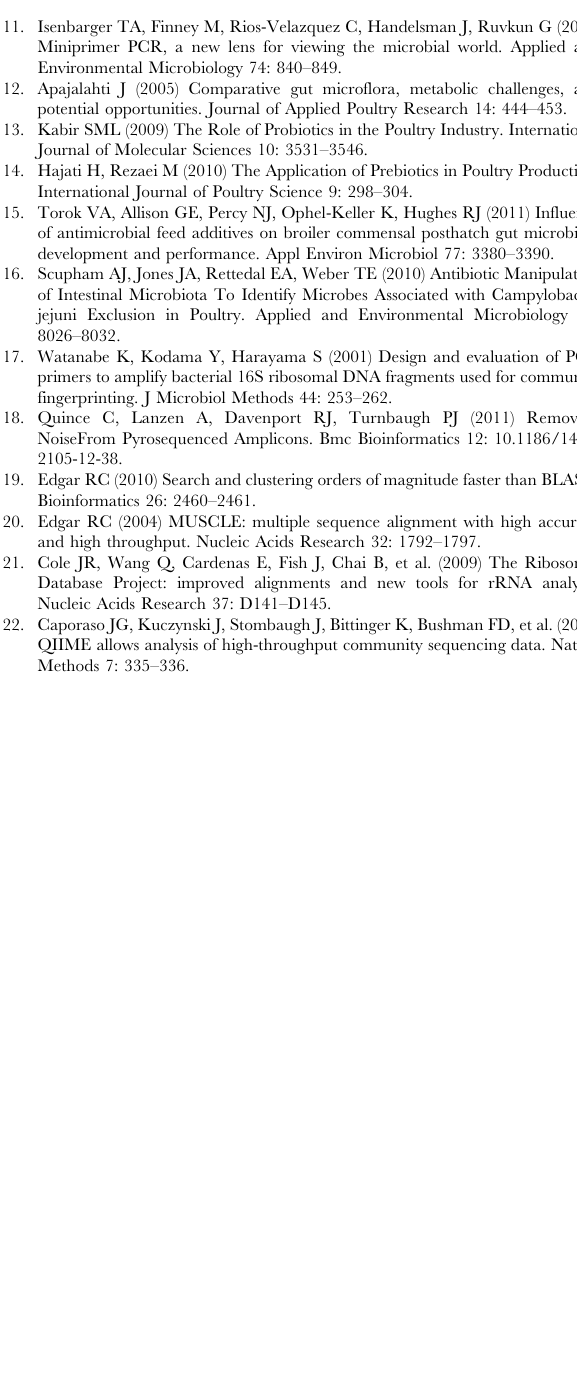
Table S4 The number of reads in each OTU obtained from each extraction procedure and their assignment using the RDP classifier and the closest BLAST match from the SILVA and NCBI nr